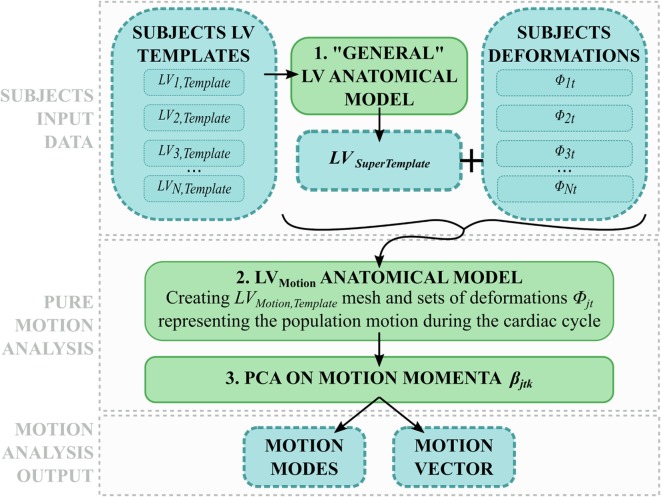
Motion analysis pipeline: (1) each subject LVj,Template is used to compute a general LV shape called LVSuperTemplate. (2) The latter is deformed with each subject-specific deformation, and all the obtained shapes are used to build a motion anatomical model (2). The resulting momenta vectors are decomposed with PCA (3), generating motion modes and motion vector describing each subject motion within the cardiac cycle.